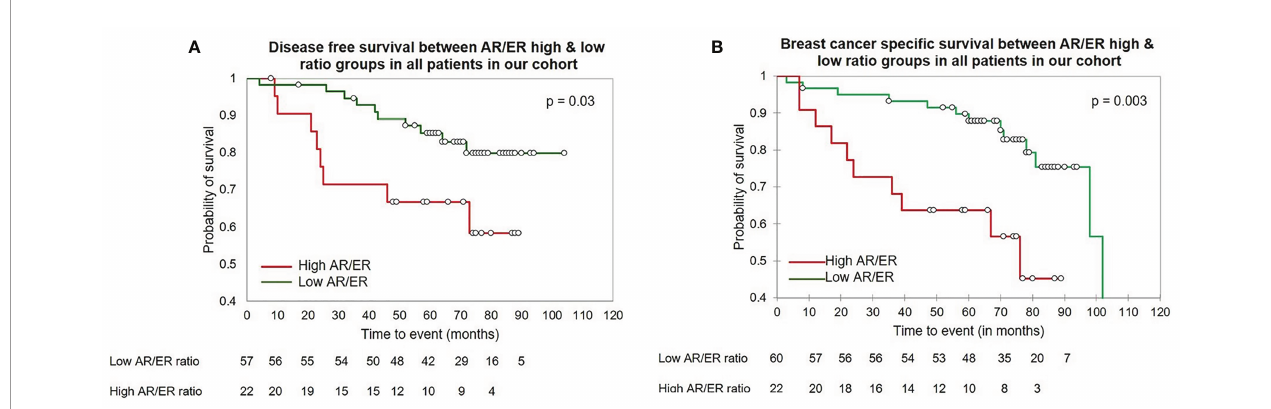
FIGURE 1 | The Kaplan – Meier survival analysis in our cohort in the patients ≤ 50 years of age (A) The disease-free survival between the high vs low AR/ER ratio groups. (B) The breast cancer speci fi c survival between the high vs low AR/ER ratio groups.